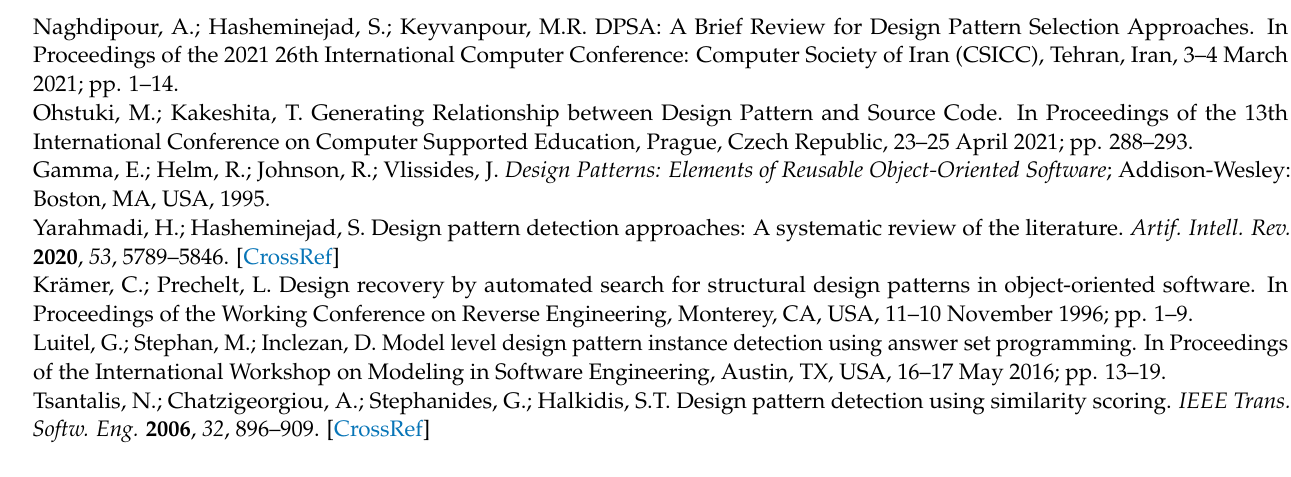
s Figure A1. UML class diagram of Subsystem s 1 1 of the open source project JHotDraw